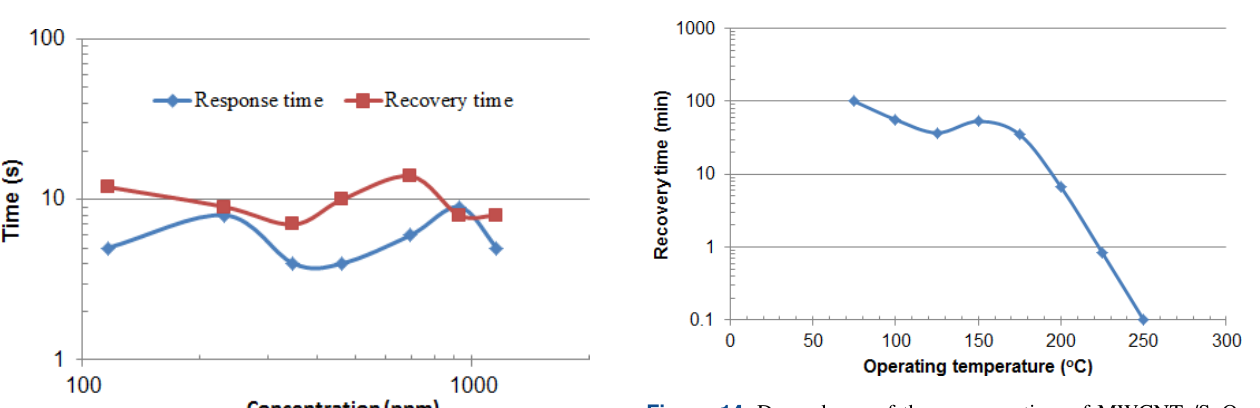
Figure 14. Dependence of the recovery time of MWCNTs/SnO 2 PG vapor sensor on operating